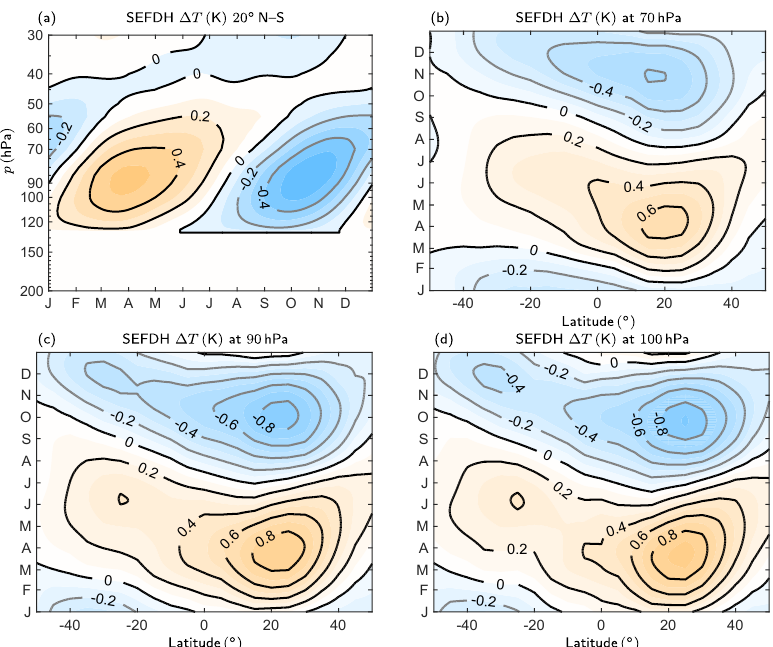
Figure 5. Temperature change (K) due to the annual water vapour cycle in an SEFDH calculation (a) averaged between 20 ◦ N and 20 ◦ S, (b) at 70hPa, (c) at 90hPa, and (d) at